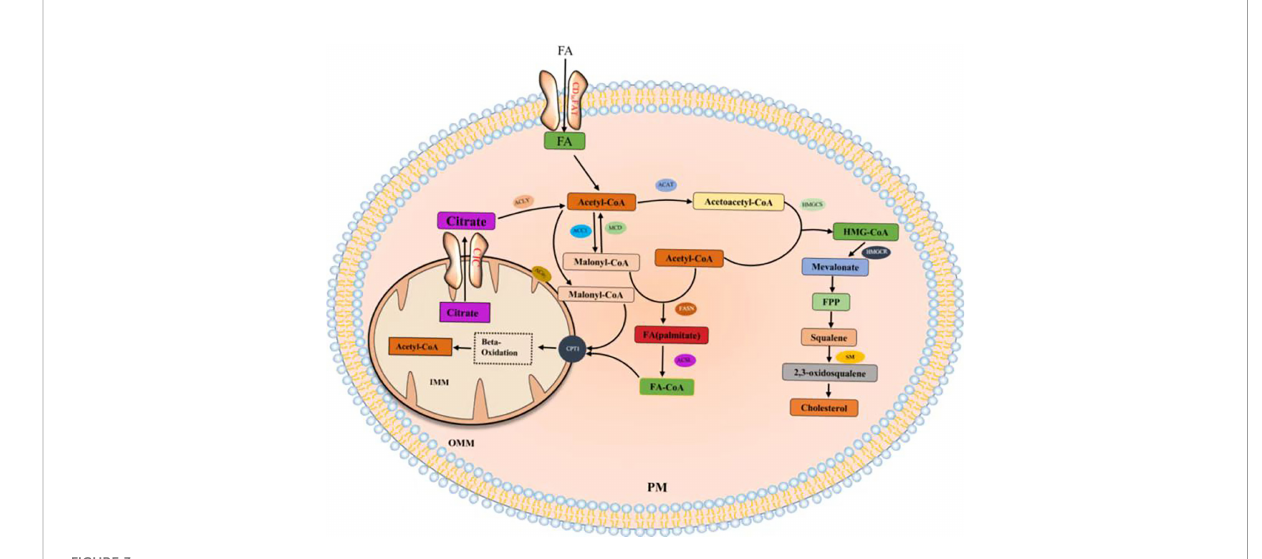
FIGURE 3 Fatty acids and cholesterol